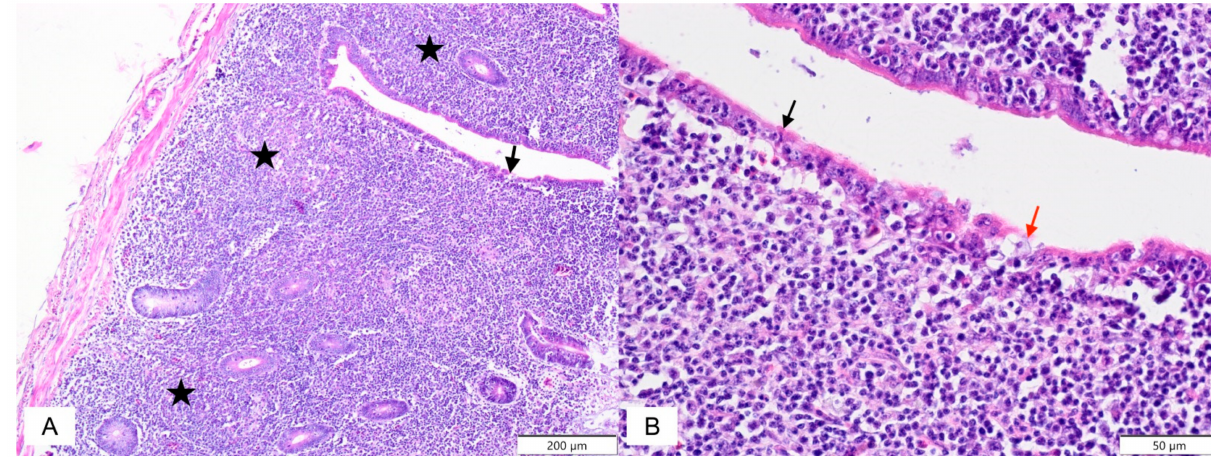
Figure 1. ( A ) Japanese quail. Jejunum. CP group. 3rd day of experiment. Diffuse infiltration of lymphoid cells (asterisk); necrosis of enterocytes (black arrow), ( B ) Higher magnification of Figure 1A, necrosis of enterocytes as indicated by nuclear pyknosis with eosinophilic cytoplasm (black arrow) and nuclear pyknosis with lose of adherence to basement membranes (red arrow). Haematoxylin and eosin